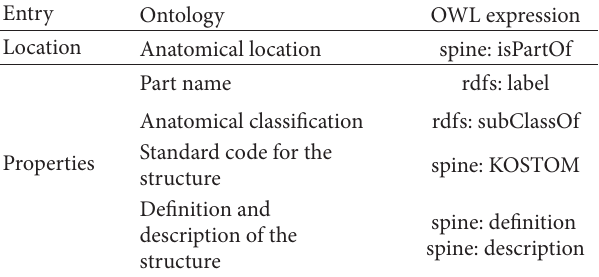
Table 1: Anatomical information represented in the